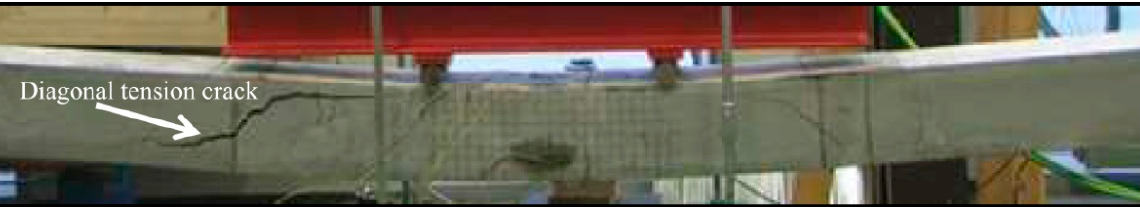
Figure 2. Concrete beam with tensile flexural BFRP reinforcement without shear reinforcement. Experimental setup for the four-point bending test [22].